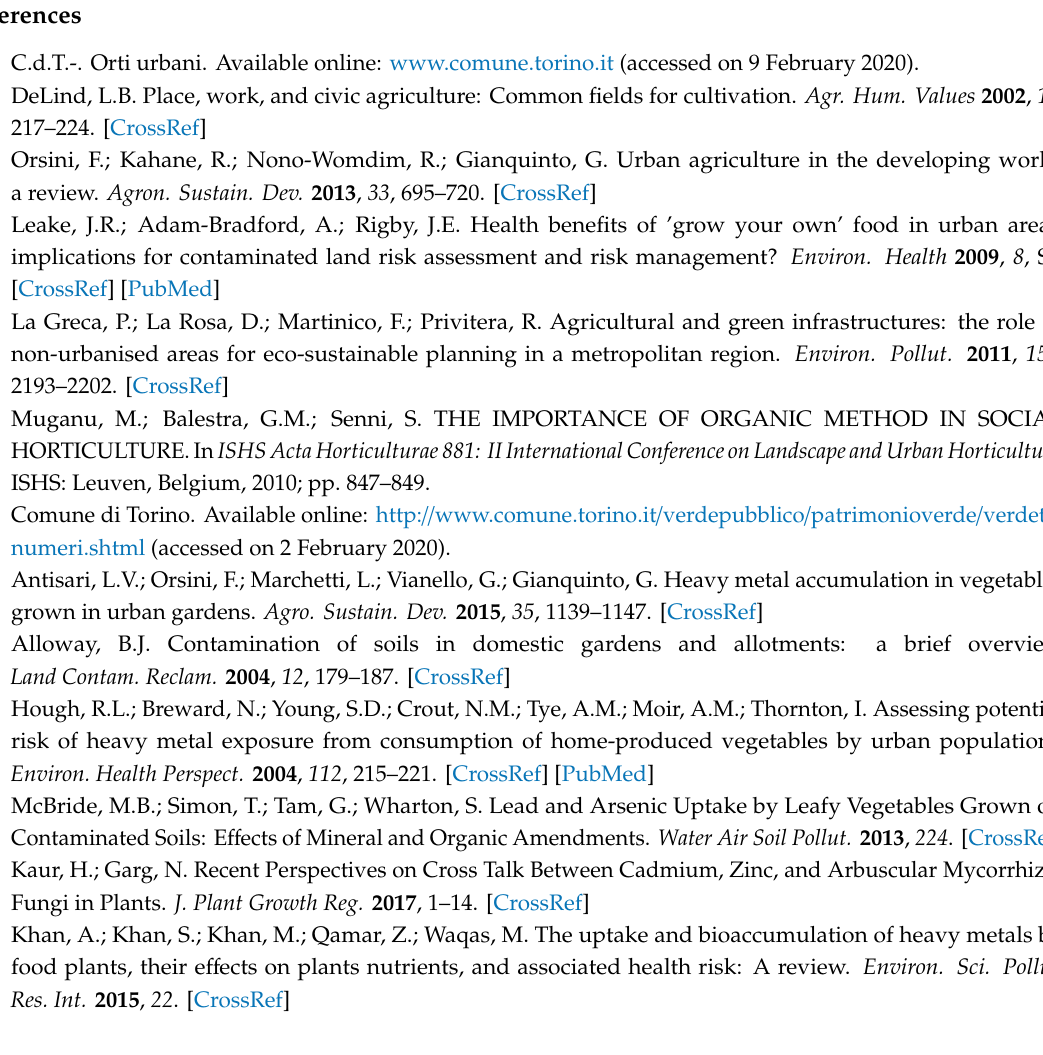
A, Table S13: Summary of multiple comparisons for pairs of Brassica oleracea TF with Tukey test. CA = plants significantly lower than the ones obtained for TF values identified by letter